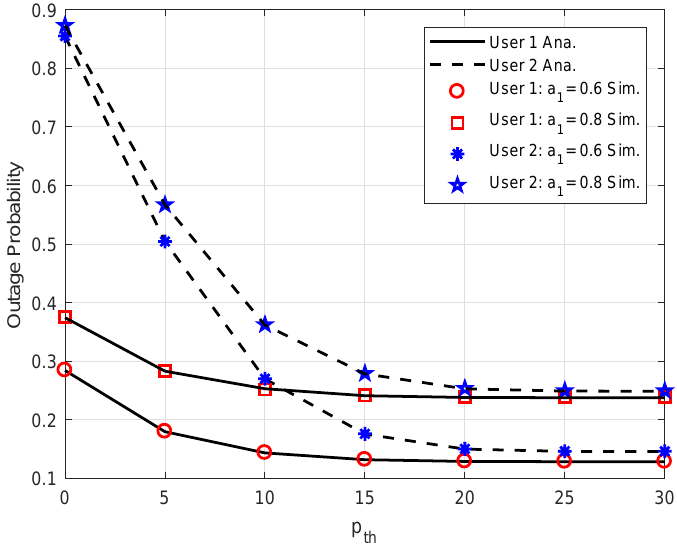
Figure 5. Outage probability of User 1 and User 2 versus